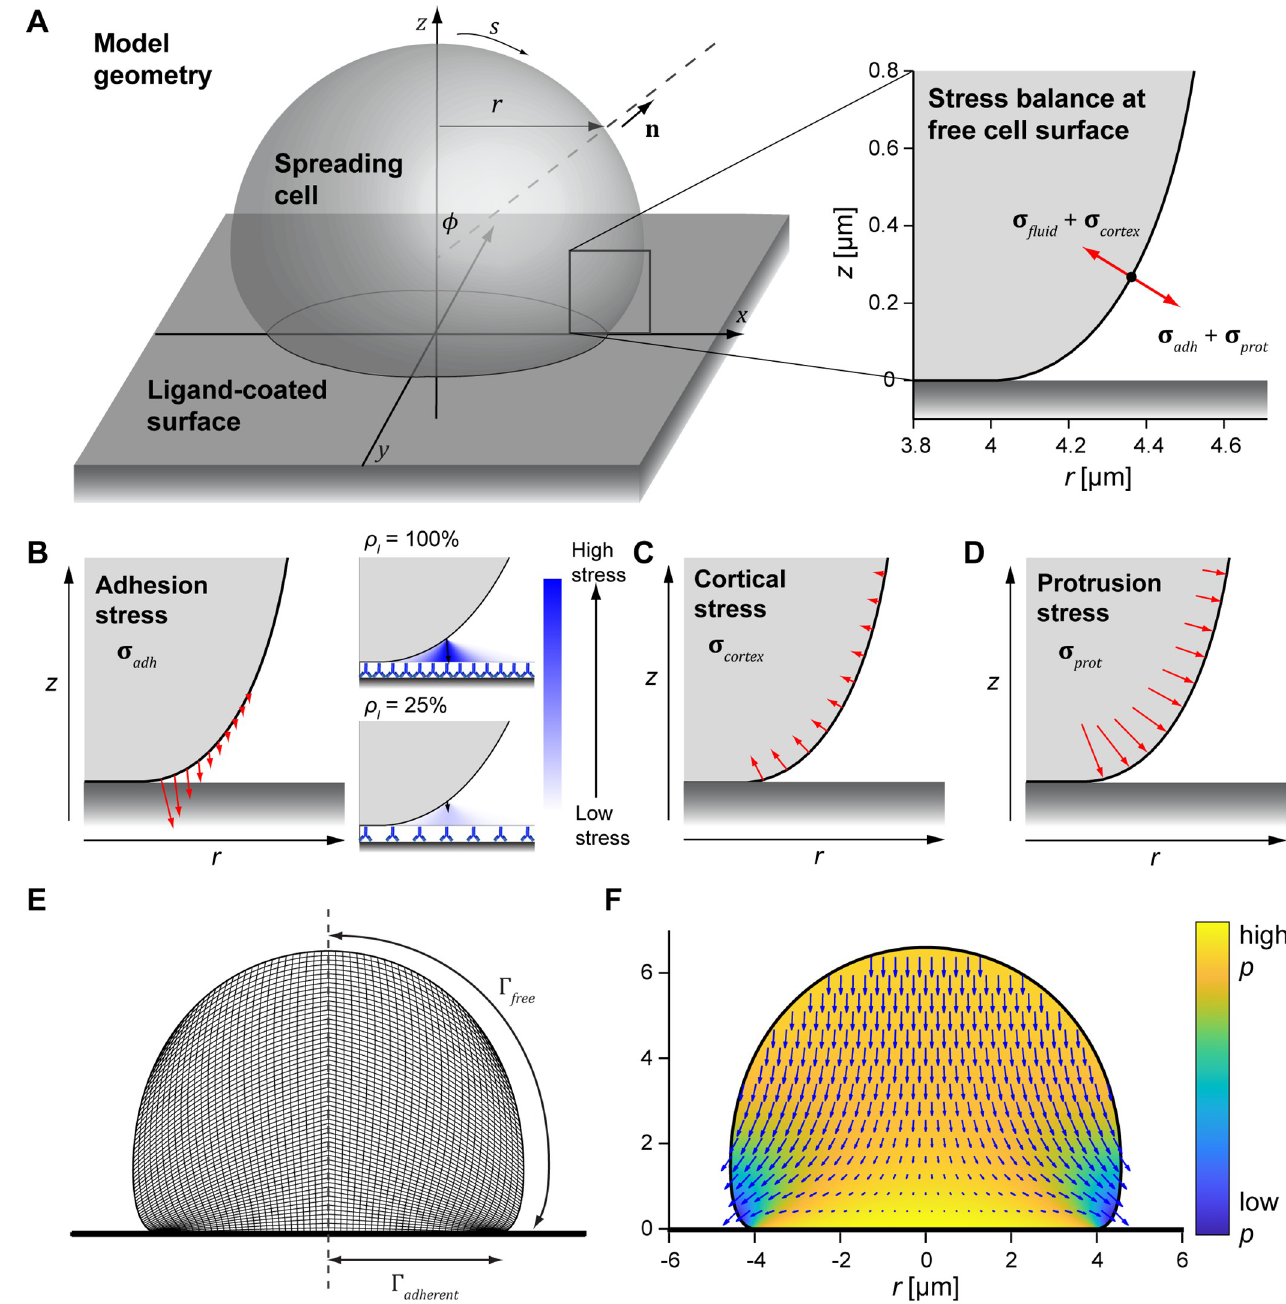
Fig 1. Illustration of our computational model of isotropic cell spreading. (A) 3D rendering shows the geometry and defines coordinates for an axisymmetric spreading cell on a flat surface. The enlarged inset (right) illustrates the stress balance at the free cell boundary. (B) Pre-contact adhesion stress effectively pulls the membrane onto the flat surface. The enlarged insets conceptually depict how the adhesion stress is computed for different ligand densities ρ l . (C) Cortical tension and membrane curvature give rise to an effective inward normal stress. (D) The protrusion stress acts normal to the cell membrane and is concentrated at the region of the membrane closest to the substrate. (E) The cross-sectional snapshot of a simulation illustrates the mesh composed of quadrilateral elements used in the calculations, with tighter element packing closer to the flat surface. The computational domain only includes half of this mesh due to axial symmetry. Boundary regions are labeled Γ , and the vertical dashed line is the symmetry axis ( r = 0) (F) This snapshot of a simulation illustrates the fluid velocity (vector field) and relative pressure (heat map) computed for a given cell shape with known boundary stresses.